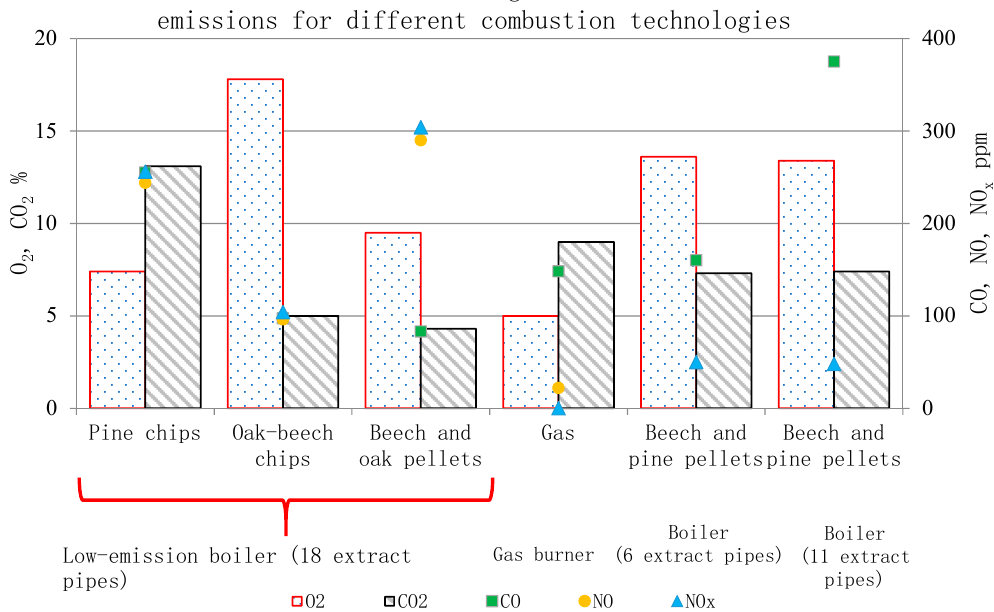
Figure 5. Comparison of exhaust gas emissions for the analysed heating devices powered by different fuels.